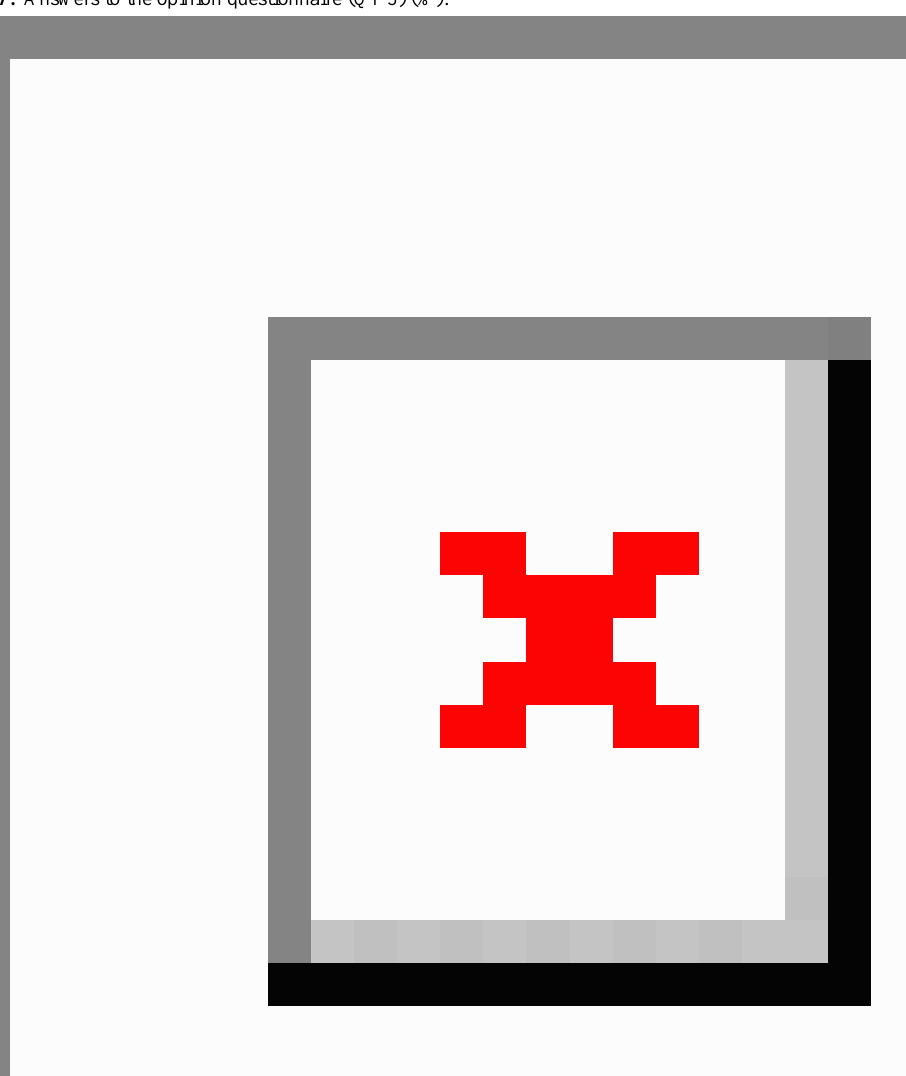
Figure 7. Answers to the opinion questionnaire (Q1-5)